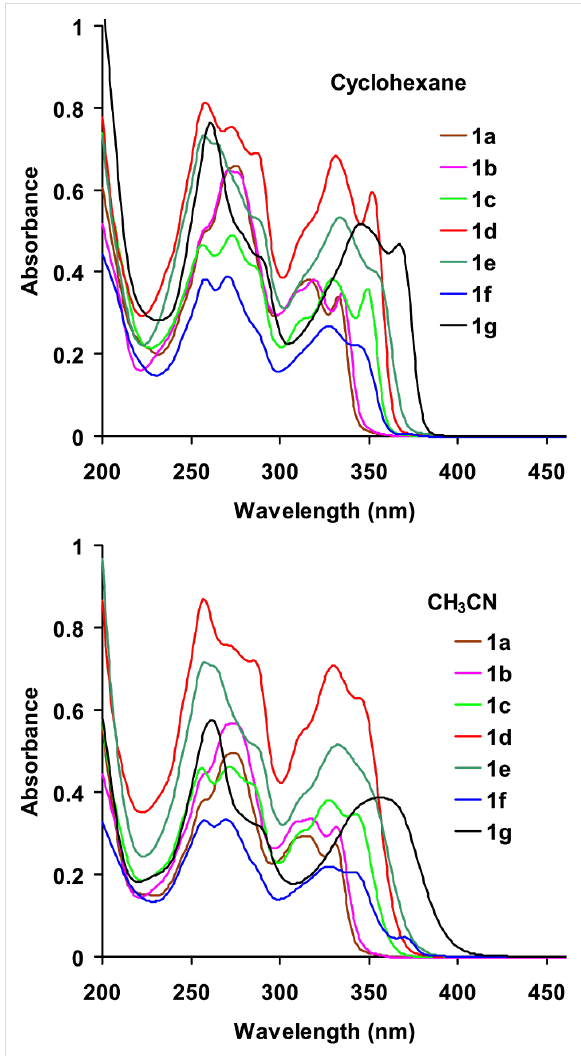
Figure 1: Absorption spectra of 1a – g in cyclohexane and acetonitrile (10 − 5